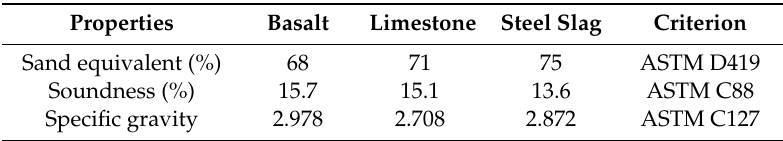
Table 1. Basic properties of three kinds of aggregate.